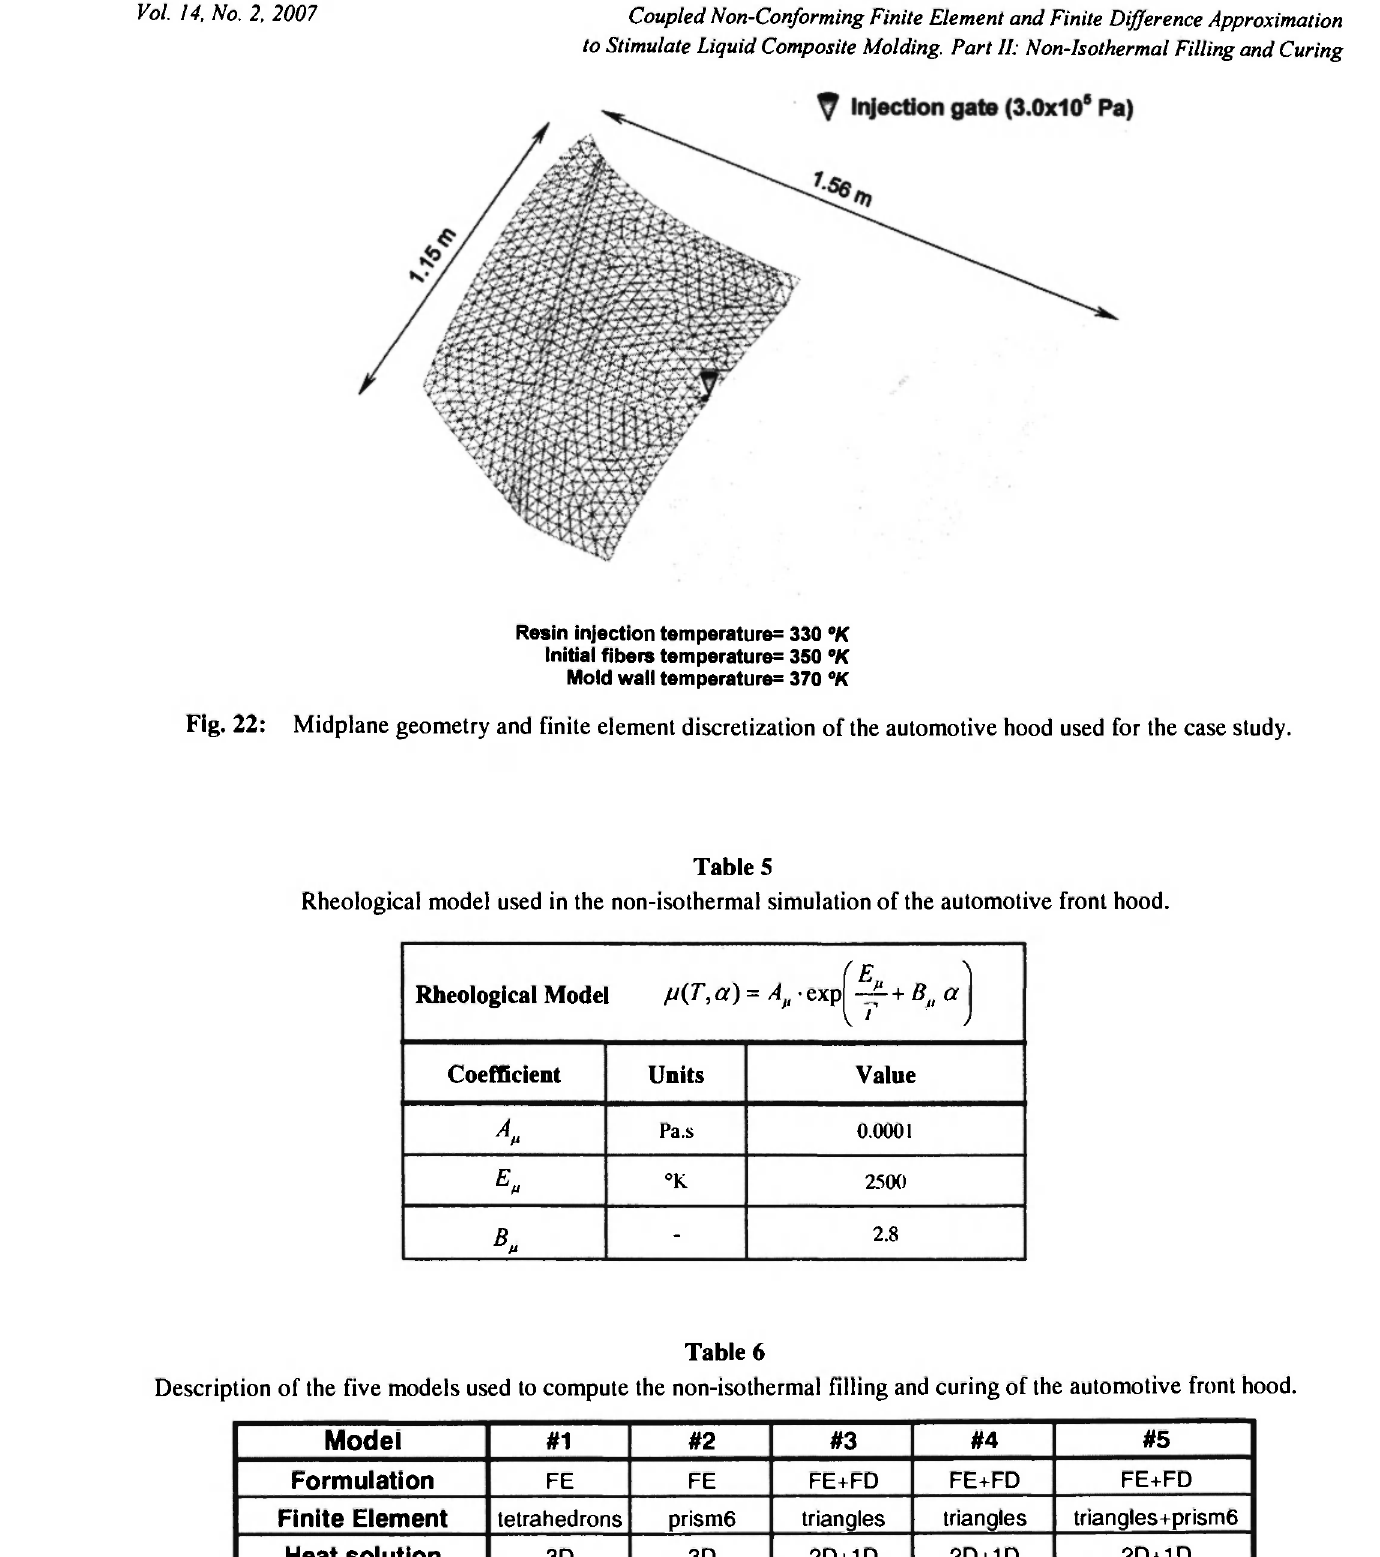
Fig. 22: Midplane geometry and finite element discretization of the automotive hood used for the case study.